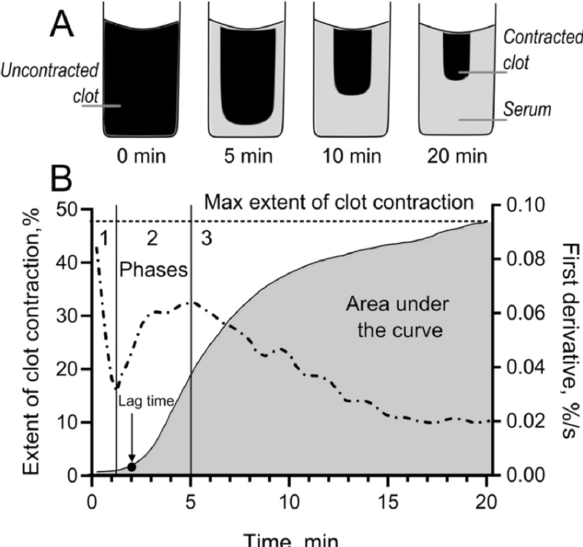
Figure 4. Differential reactivity of platelets isolated from the blood of SLE patients and healthy donors (control) in response to stimulation. Flow cytometry was used to measure a fraction of platelets expressing P-selectin ( A ) or active α IIb β 3 ( B ) before and after activation with 50 µM TRAP. Gel-filtered platelets were isolated from the blood of 11 active SLE patients (black dots) and 8 or 7 healthy subjects (white dots) for the measurements of the surface expression of P-selectin and active α IIb β 3, respectively. ns = not significant. Mann–Whitney test.